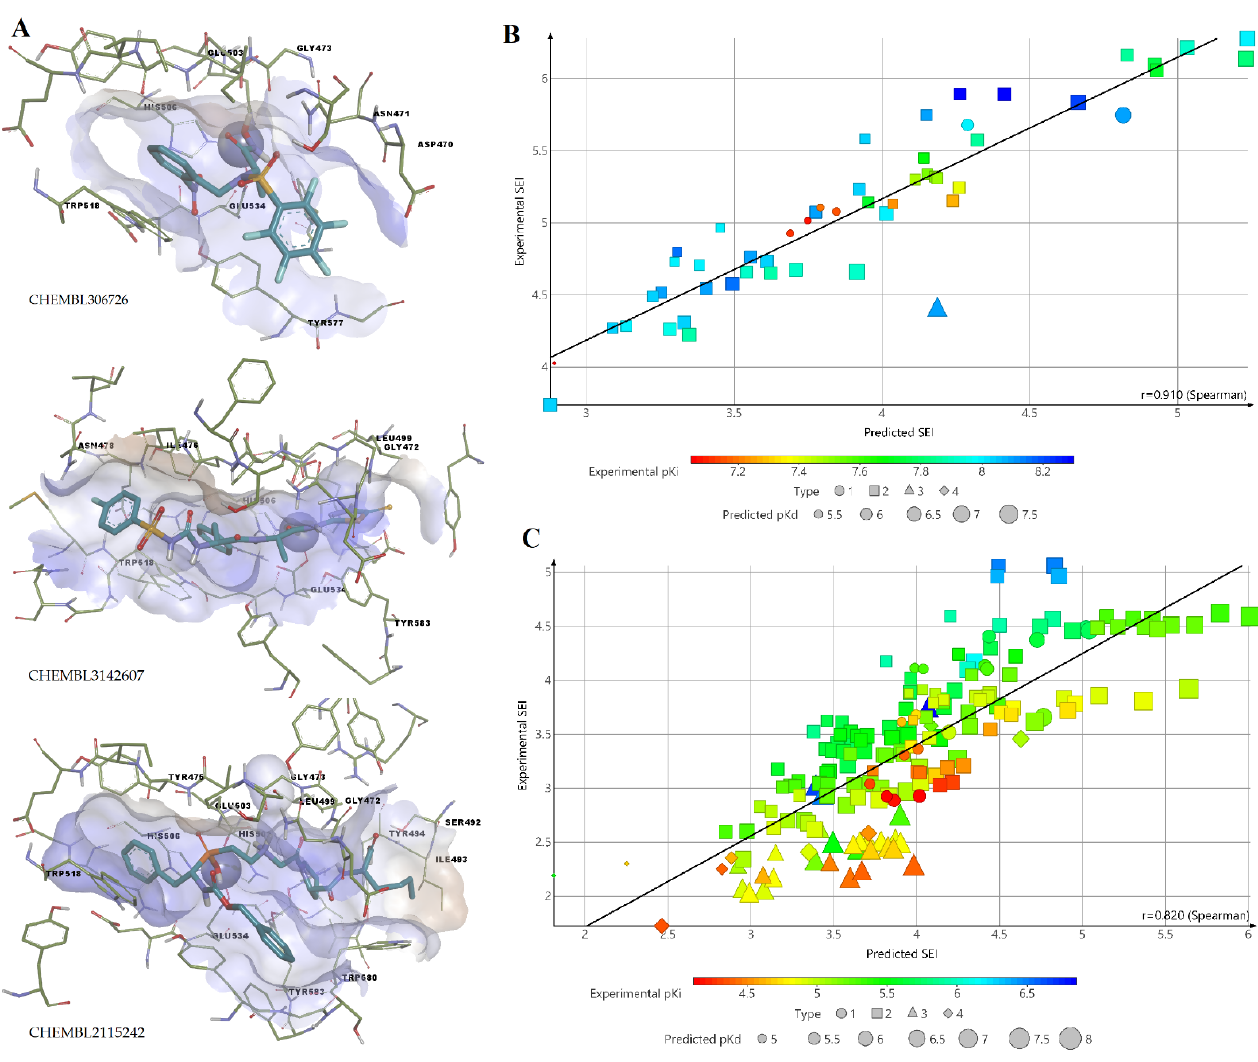
Figure 6. Docking analysis results: ( A ) Binding poses of three selected inhibitors for ColA model validation; ( B ) correlation diagram between experimental and predicted SEI values for compounds from BCI set with strong activity; ( C ) correlation diagram between experimental and predicted SEI values for compounds from BCI set with weak activity.